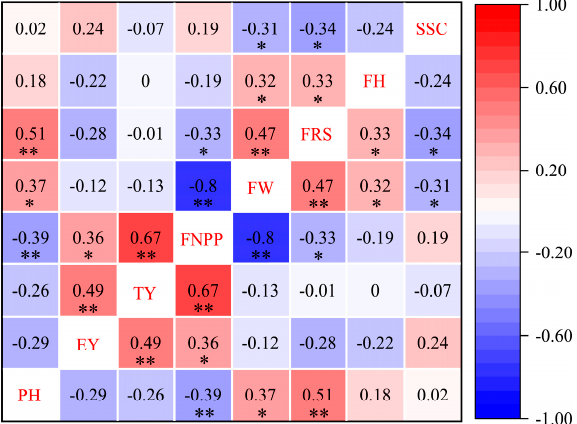
Figure 1. A heatmap depicting Pearson’s correlation coefficients for different characters of 45 tomato hybrids. Sample size, N = 45. The degree of correlation is color coded according to the color key on the right. The blue and red boxes indicate negative and positive correlation coefficients,